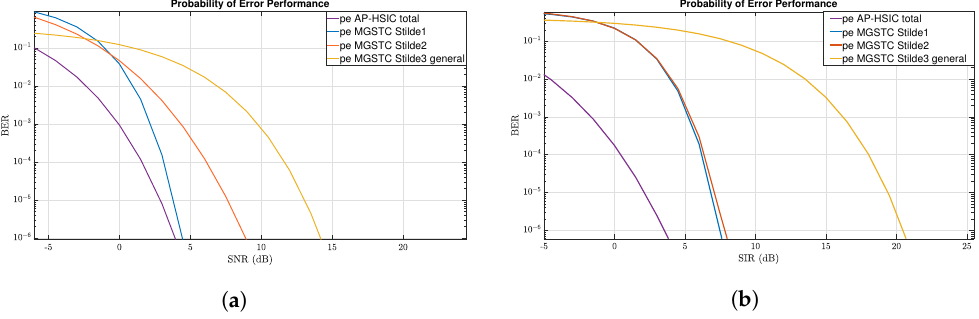
Figure 7. BER vs. SNR of MGSTC and AP-HSIC. ( a ) Comparison under QPSK modulation in the presence of PBN interference. ( b ) Comparison under QPSK modulation in the presence of general